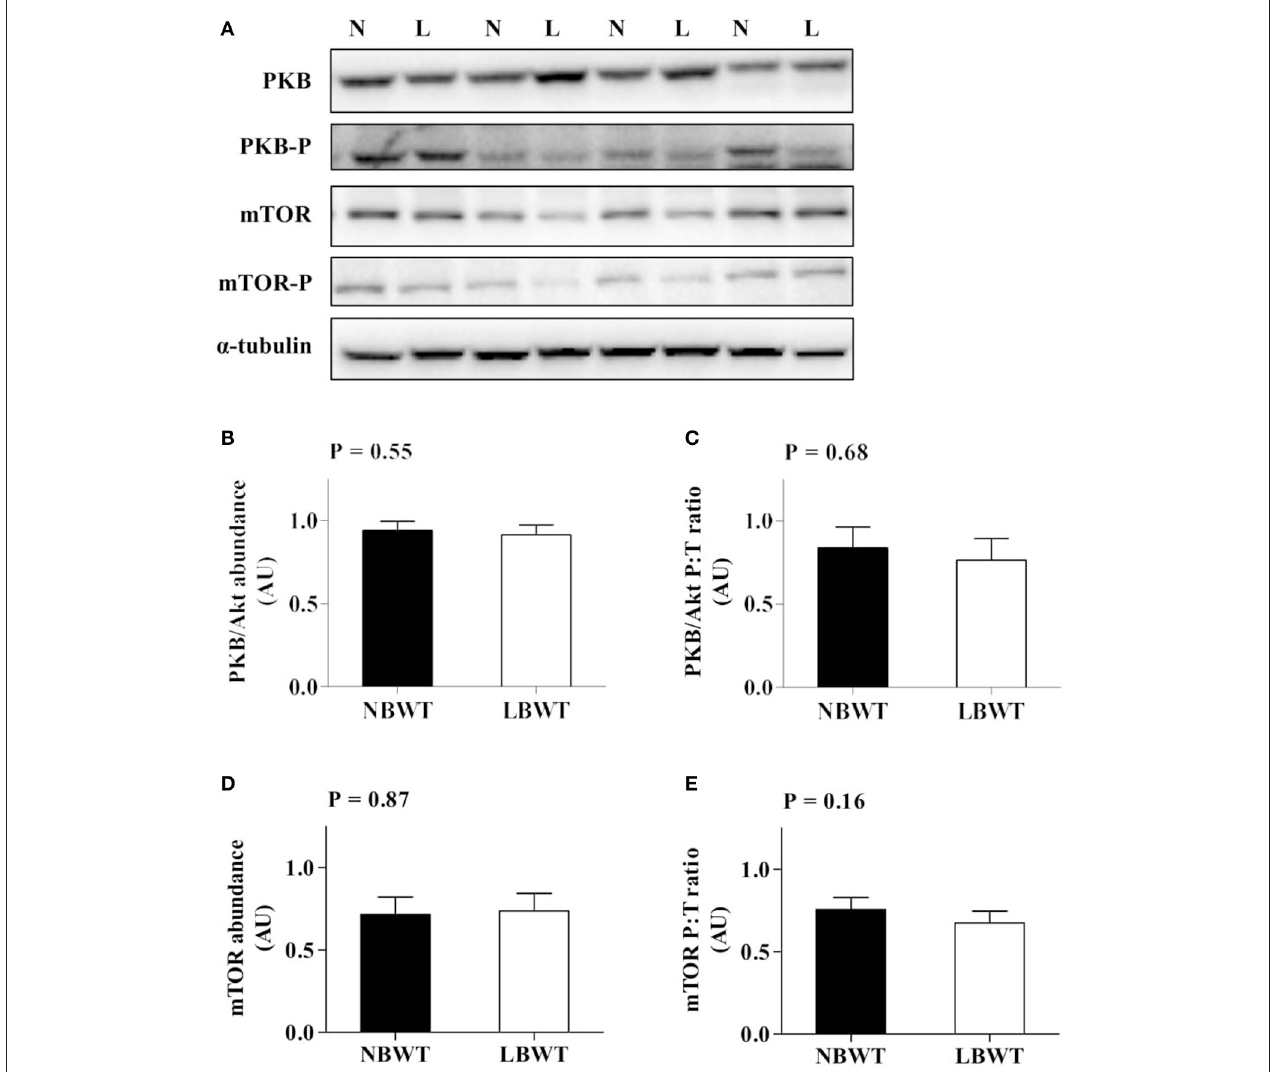
FIGURE 4 | Protein abundance and phosphorylation of PKB/Akt and mTOR in longissimus dorsi muscle of low-birth-weight (LBWT) and normal-birth-weight (NBWT) neonatal pigs. (A) : Representative western blots from four pairs of LBWT and NBWT pigs (N, NBWT; L, LBWT). (B – E) : Protein abundance and phosphorylation of PKB/Akt and mTOR. Abundance was normalized to α -tubulin and phosphorylation normalized to the corresponding non-phospho-proteins. Results are means ± SE. n =